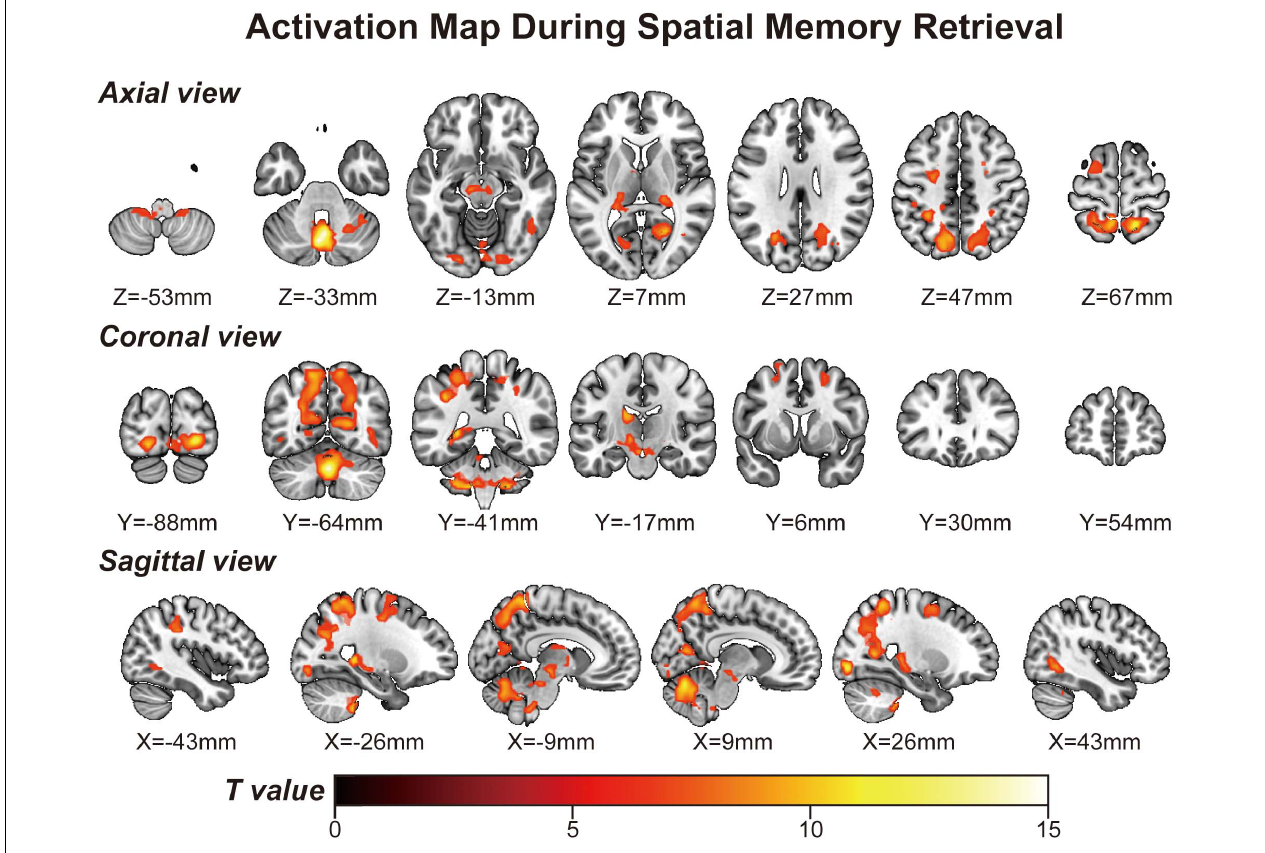
FIGURE 2 | Activation map obtained from the “navigational vs. non-navigational” state (at p < 0.001, corrected by FWE for p < 0.05 at the cluster level). The hot bar at the bottom labels T value from 0 to 15. Numbers represent X (sagittal view), Y (coronal view), and Z (axial view) coordinates in the MNI space.